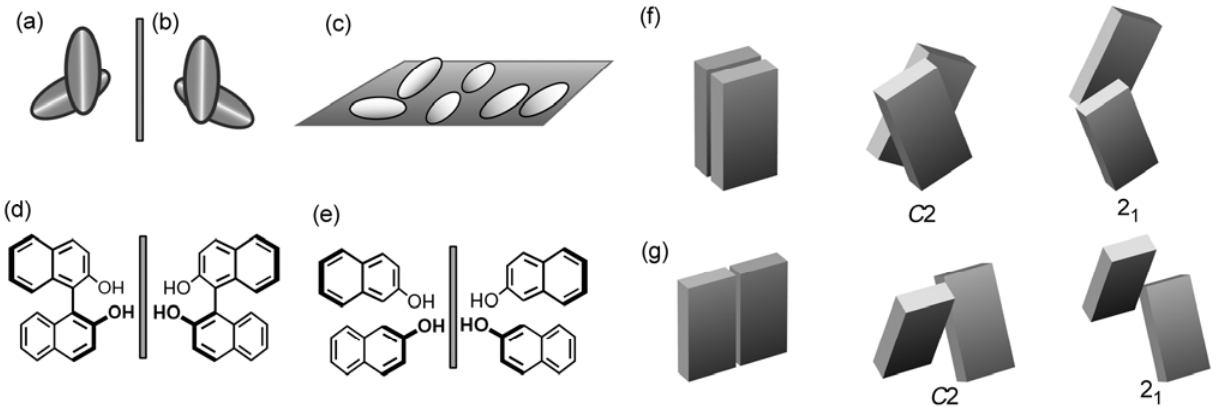
Figure 10. Supramolecular tilt chirality of assemblies of two materials. An assembly of two polyhedrons with tilt chirality (a), its mirror image (b), their assemblies without tilt chirality (c), 1,1’-bi-2-naphthol with axial chirality (d), mirror images of hypothetical assemblies made by a bond collapse of 1,1’-bi-2-binaphthol (e), bimolecular assemblies of planar or C 2 symmetry in a face-to-face (f) or an edge-to-edge mode molecules with 2 1